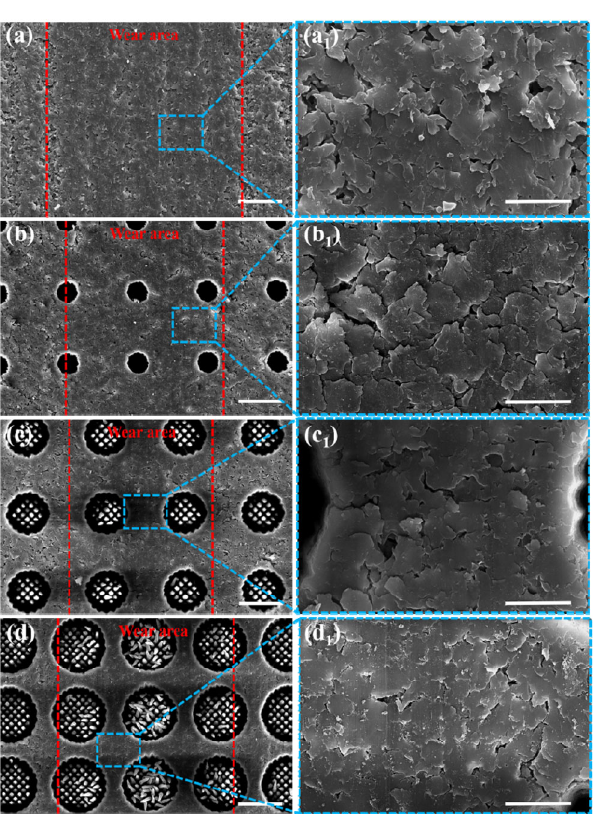
Fig. 7 Surface morphology of (a) PPI, (b) HPPI-T50, (c) HPPI- T100, and (d) HPPI-T150 after the friction experiment (the scale bar in the left image is 100 µm, and right is 30